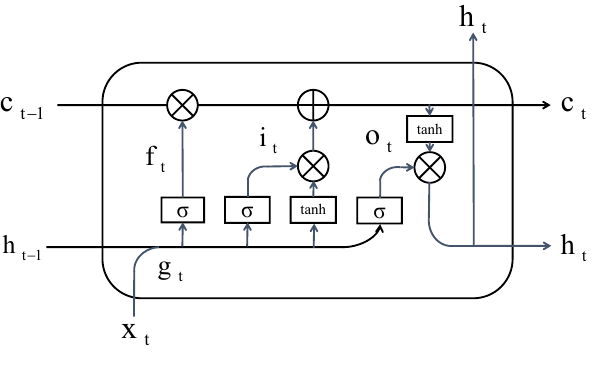
Figure 2. The detail structure of LSTM